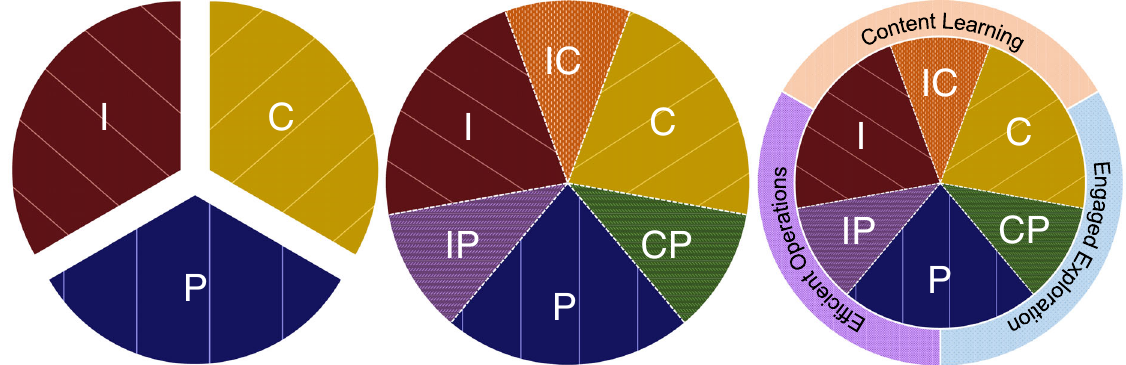
FIG. 6. Summary of the evolution of the pedagogical-modes model as discussed throughout this work: (left) the model as articulated by Hinko, where modes form distinct categories; (center) a mixed-modes model that situates the modes as a neighboring clusters of traits, allowing for blending between them; and (right) the comprehensive taxonomy, with both mixed modes and the overarching pedagogical objectives that mediate UEs ’ choices among and implementations of the solo modes and their mixed-mode